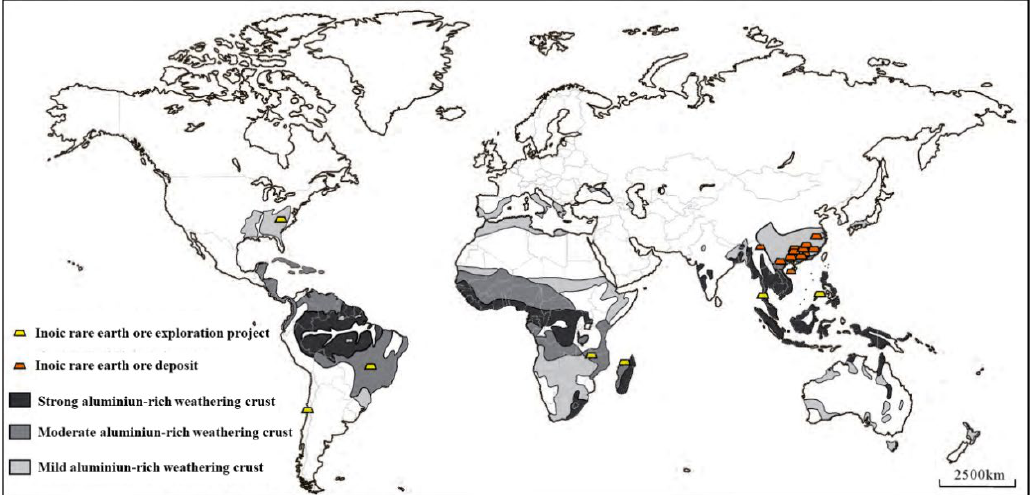
Figure 1. Distribution of global weathering crust, ionic rare earth deposits, and related projects [15]. Zhao et al. [15] compared various ionic rare earth deposits according to the relevant literature of ionic rare earth ores, as shown in Table 1, and discussed the influence of climate on the mineralization of ionic rare earth ores. In South China, which has a subtropical climate, the annual average temperature is 16~22 °C, the annual average precipitation is 1000~1800 mm, the thickness of the weathering crust is mostly 15~35 m, and the content of rare earth can reach thousands of ppm (1000n × 10 − 6 ). There are light and heavy rare earth deposits, mainly medium and heavy rare earth deposits. South Carolina, which also has a subtropical climate, has an annual average temperature of 17 ◦ C and an annual average precipitation of 1150 mm. The thickness of the weathered crust in the area is between 10 m and 20 m, and the content of rare earth is 93 × 10 − 6 ~757 × 10 − 6 . However, Thailand and other Southeast Asian countries have a tropical climate, with an annual average temperature of more than 25 ◦ C and an annual average precipitation of more than 2000 mm concentrated in the rainy season, and the thickness of the weathering crust is usually only 1~10 m. There are mainly light rare earth deposits. In the Philippines, the thickness of the weathering crust is less than 5 m, and the rare earth content is only tens of ppm, even lower than that in bedrock. The thickness of the weathering crust and the content of rare earth elements are higher in subtropical areas. In the tropical climate, the weathering alteration coefficient of the weathering crust is significantly higher than that in the subtropical climate, and the rock weathering is more thorough. The strong weathering means that rare earth elements are more likely to migrate and lose with the surface water, which is not conducive to rare earth mineralization.